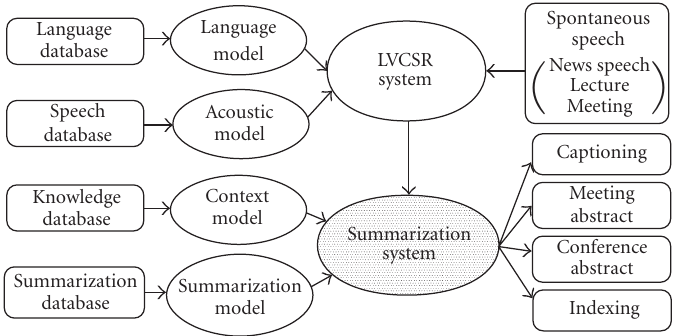
Figure 1: Automatic speech summarization system.